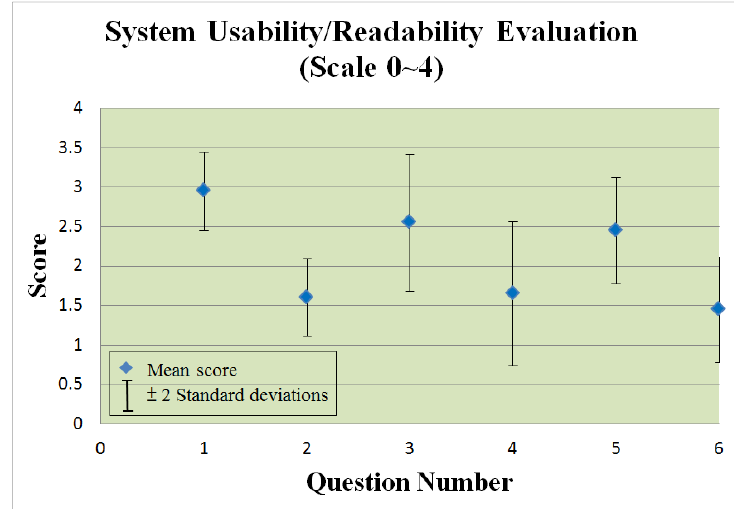
Figure 18. System usability/readability evaluation for